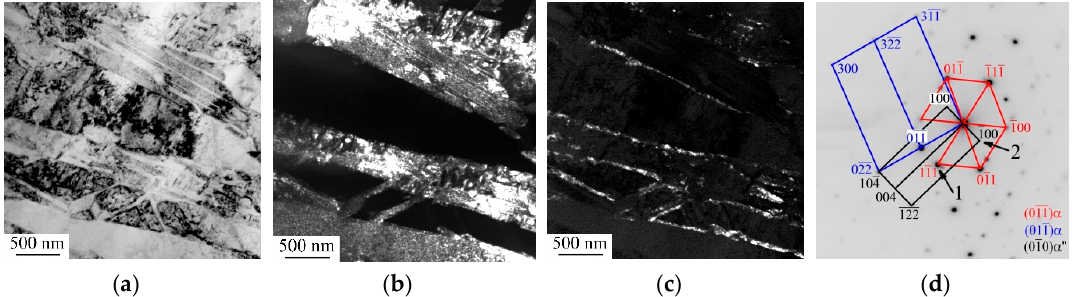
Figure 13. TEM bright- ( a ) and dark-field images ( b,c ) and associated SAED pattern ( d ) of the microstructures of the melted surface layer of the EBF 3 -fabricated Ti–6Al–4V sample subjected to electron beam treatment. b —dark-field TEM image obtained with the 11(cid:3364)1 α -Ti reflection (marked by an arrow 1 in ( d )). c —dark-field TEM image obtained with the 1(cid:3364)00 α″ -Ti reflection (marked by an arrow 2 in ( d )).